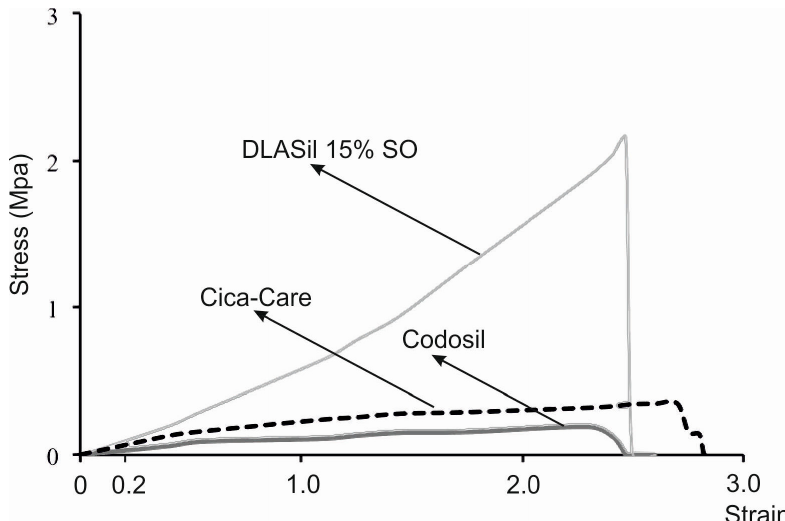
Figure 5. Comparison of the strain – stress curves obtained for Codosil™ and Cica-Care patches with Gumosil AD-1 film containing 15% w / w of silicon oil (SO). Table 1. Tensile properties of examined silicone films: Gumosil AD-1 with different content of silicon oil (SO) and commercially available products (mean values ± standard deviation, n ≥ 8).